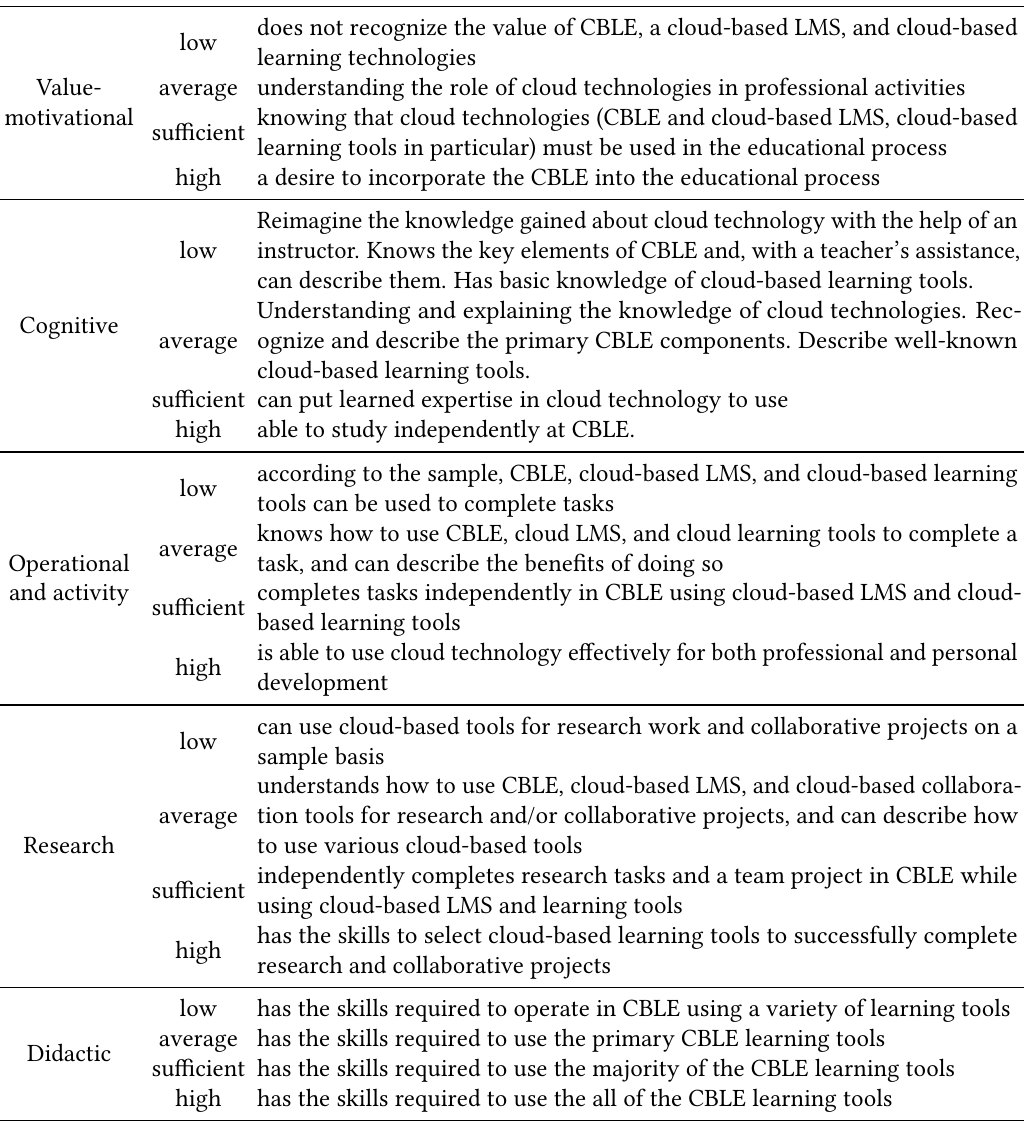
Table 1 Description of the levels of digital competence of CS bachelors in the use of CBLE.